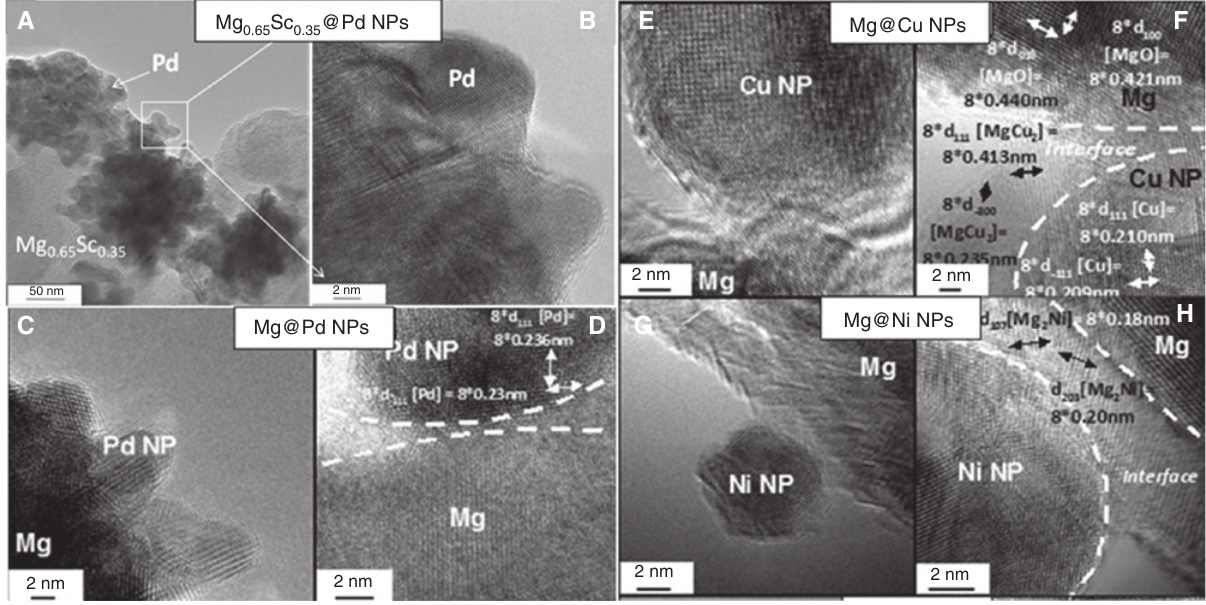
Figure 11: Examples of inorganic nanostructures with the absence (A–D) or presence (E–H) of an interphase compound. (A, B) Magnesium- scandium alloy decorated with agglomerated Pd NPs. Reprinted with permission from Couillaud S, Kirikova M, Zaïdi W, Bonnet JP, Marre S, Aymonier C, Zhang J, Cuevas F, Latroche M, Aymard L, Bobet JL, J. Alloys Compd. 2013, 574, 6–12 [76], Copyright 2013 Elsevier. (C, D) Magne- sium surface decorated with agglomerated Pd NPs. Reprinted with permission from Aymonier C, Denis A, Roig Y, Iturbe M, Sellier E, Marre S, Cansell F, Bobet JL, J. Supercrit. Fluids 2010, 53, 102–107 [19], Copyright 2010 Elsevier. (E, F) Magnesium surface decorated with aggregates/ single Cu NPs with the formation of an interphase compound of MgCu [19]. (G, H) Magnesium surface decorated with aggregates/single Ni 2 NPs with the formation of an interphase compound of Mg Ni 2